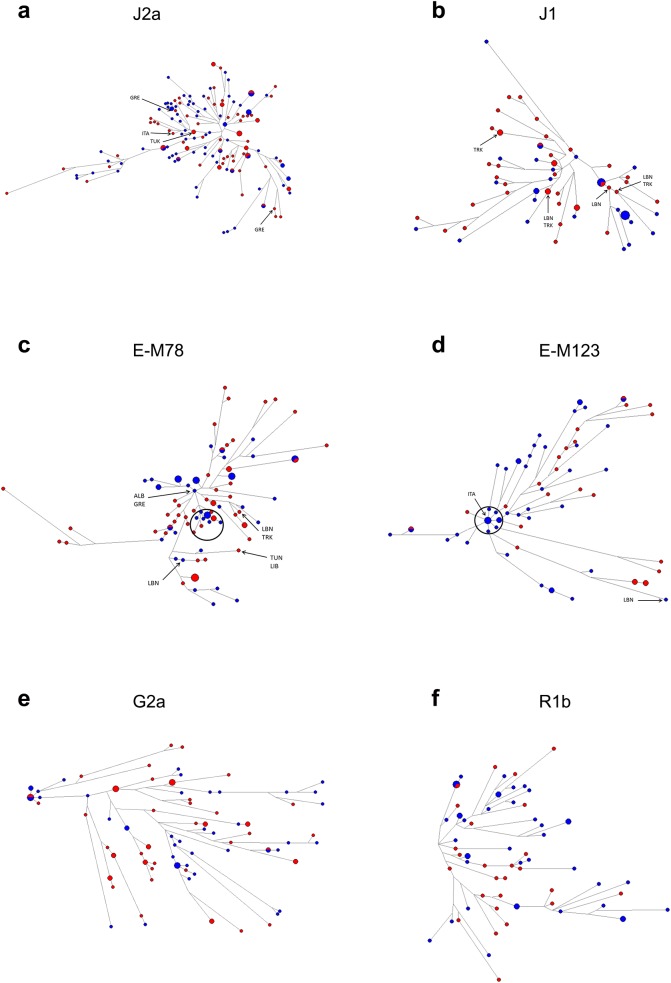
Median-joining networks for haplogroups (a) J2a, (b) J1, (c) E-M78, (d) E-M123, (e) G2a, and (f) R1b. Median Joining Network based on 17 Y-STR loci. For each network, blue colour indicates GCy haplotypes and red colour TCy haplotypes. Circles are sized according to the number of individuals sharing the haplotype, with the smallest circles representing one individual. The lengths of the connecting lines are proportional to the number of mutational steps separating two haplotypes. Haplotypes shared with surrounding populations are labelled with the corresponding country where the exact 17/17 haplotype match is found (GRE: Greece, TUR: Turkey, LEB: Lebanon, EGY: Egypt, LIB: Libya, TUN: Tunisia, ALB: Albania, CRO: Croatia)